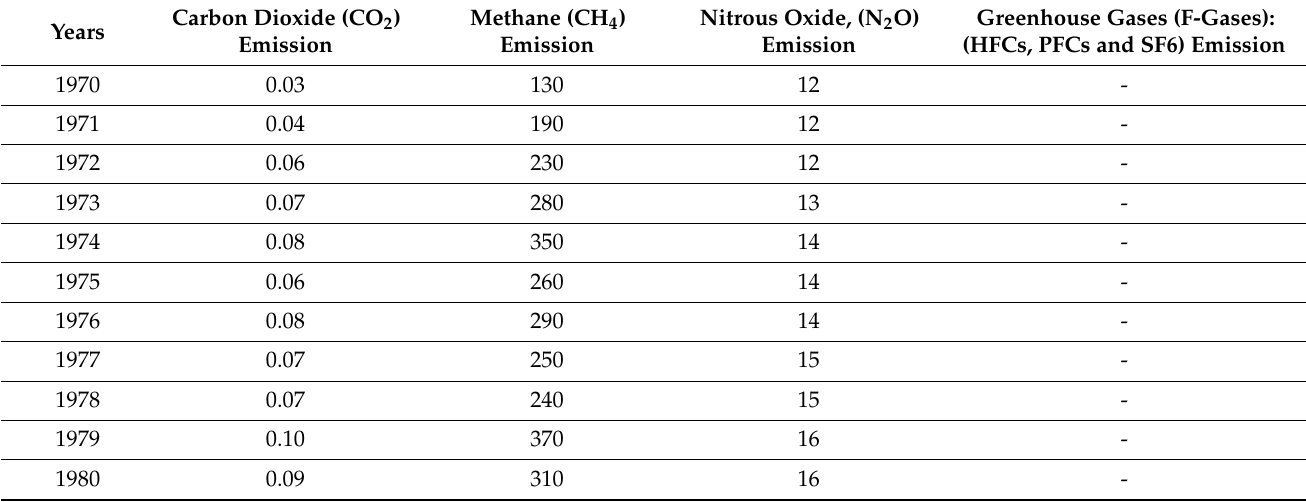
Table 3. Atmospheric emissions from 1970 to 2019 in